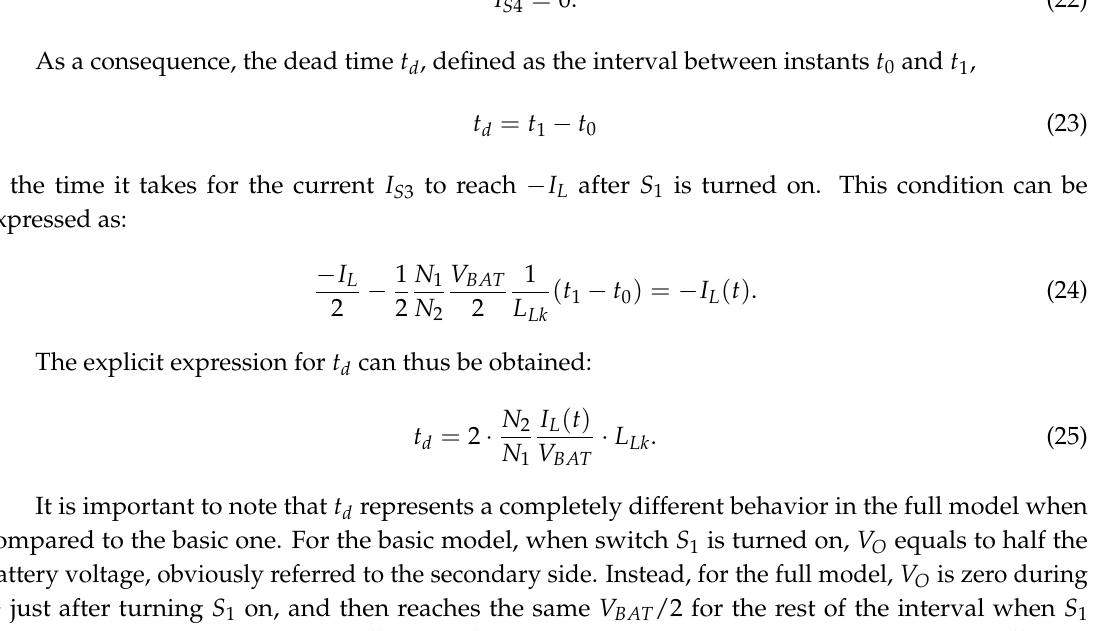
Figure 12. Additionally, the Equivalent Series Resistor, ESR C , of the filter capacitor C has been included.